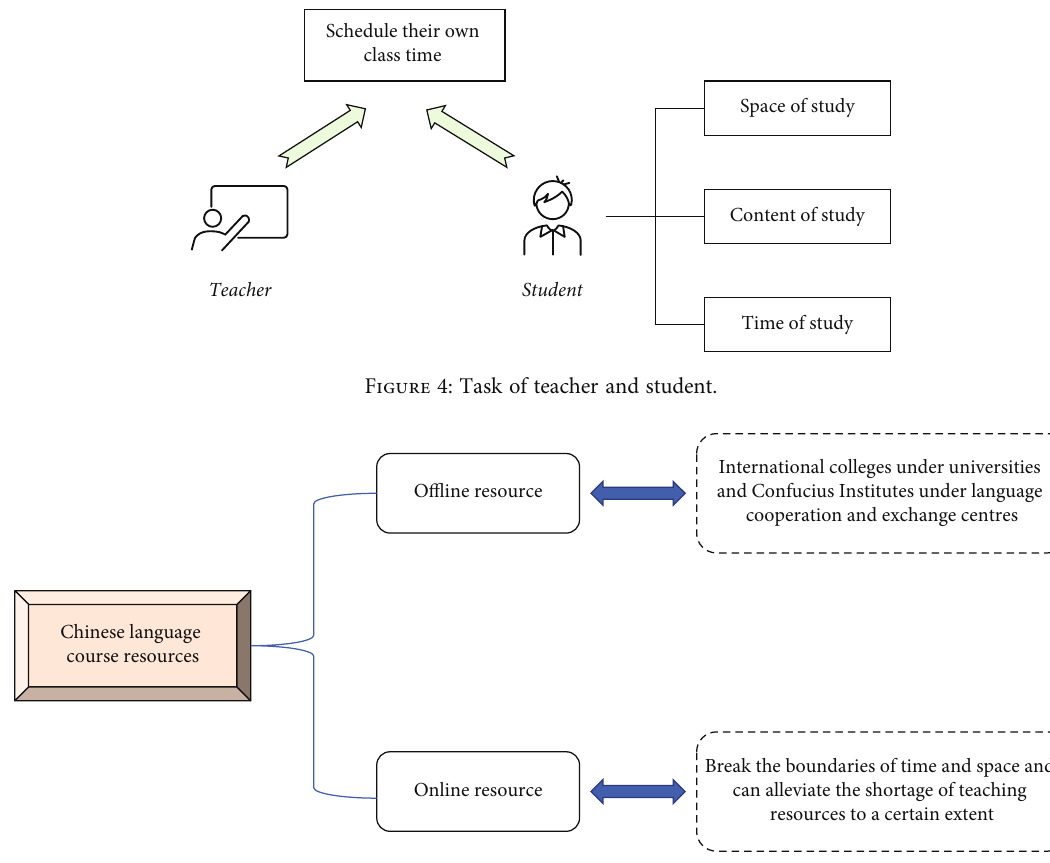
Figure 5: Chinese language course